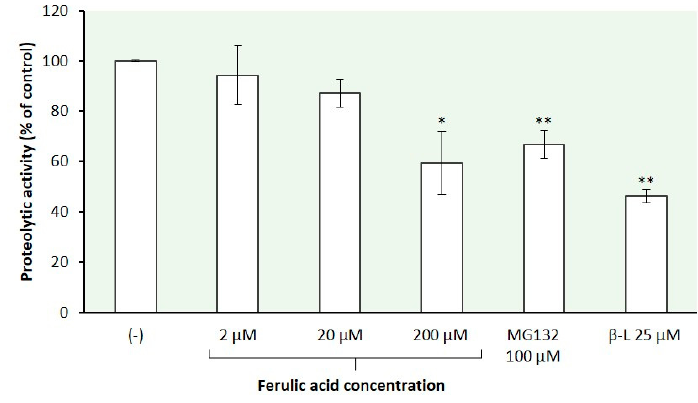
Figure 4. Effect of ferulic acid on the absolute rate of protein degradation by the 26S proteasomes isolated from T. versicolor . Reaction mixtures containing the proteasome solution were preincubated with ferulic acid at various concentrations for 30 min before the addition of a model protein substrate ( β -casein). Proteasome inhibitors MG132 and clasto-lactacystin β -lactone ( β -L) were used for comparison. The rate of protein degradation was spectrofluorometrically quantified by the fluorescamine assay for release of free α -amino groups generated upon the cleavage of peptide bonds in β -casein. The control reaction mixture contained the DMSO solvent. The data represent means ±SD of four independent experiments performed in duplicate (* p < 0.05 and ** p < 0.01).